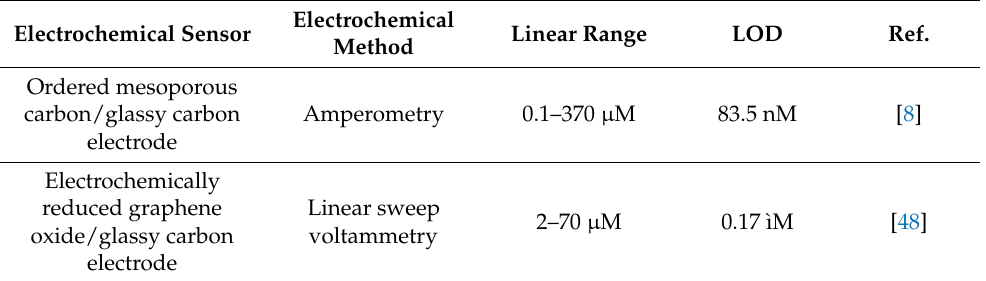
Table 1. Comparison of the efficiency of the MoS 2 NSs-SPE with literature modified electrodes for INZ determination.